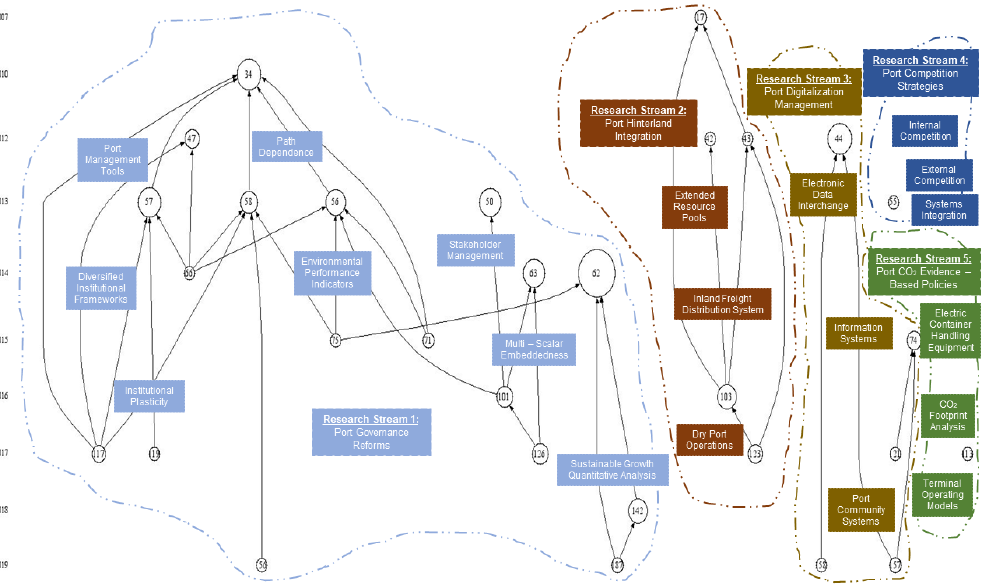
Figure 5. The emerging green port research domain intellectual structure regarding the five concurrent research streams. research